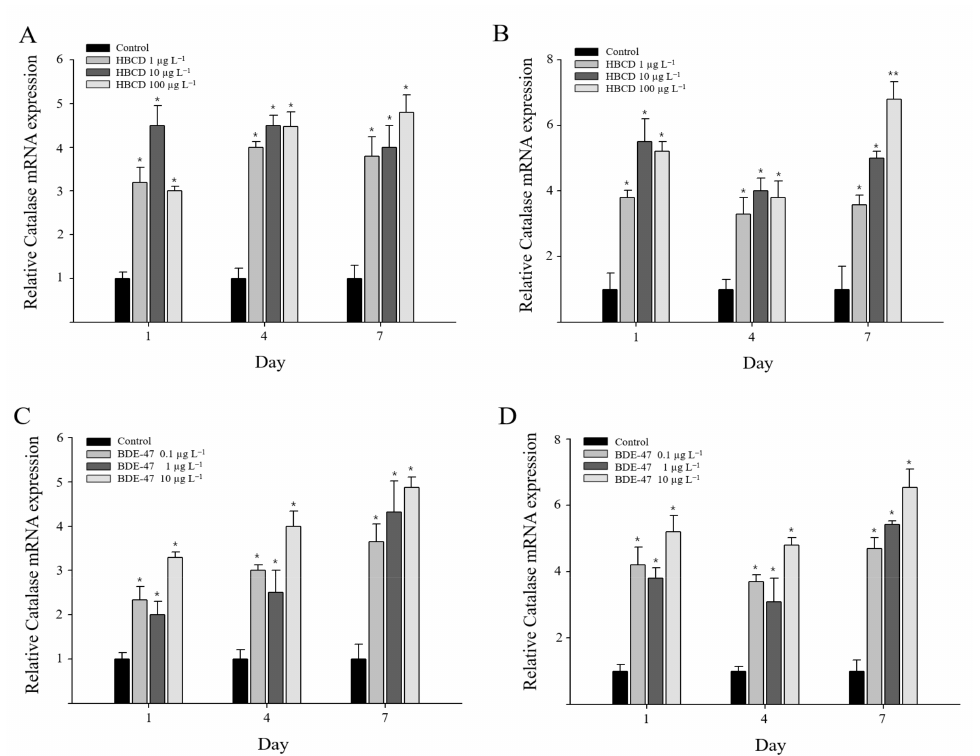
Figure 3. Relative transcriptional levels of catalase gene in M. japonicus gills ( A , C ) and hepatopancreas ( B , D ) after exposures to 1, 10, and 100 µ g L − 1 HBCD ( A , B ) and 0.1, 1, and 10 µ g L − 1 BDE-47 ( C , D ). Exposure periods were days 1, 4, and 7. GAPDH levels were used for normalization of the values. All values are indicated as mean ± SD. Statistically significant differences are presented by an asterisk mark (* p < 0.05 and ** p < 0.01) compared with the relative control value ( catalase =